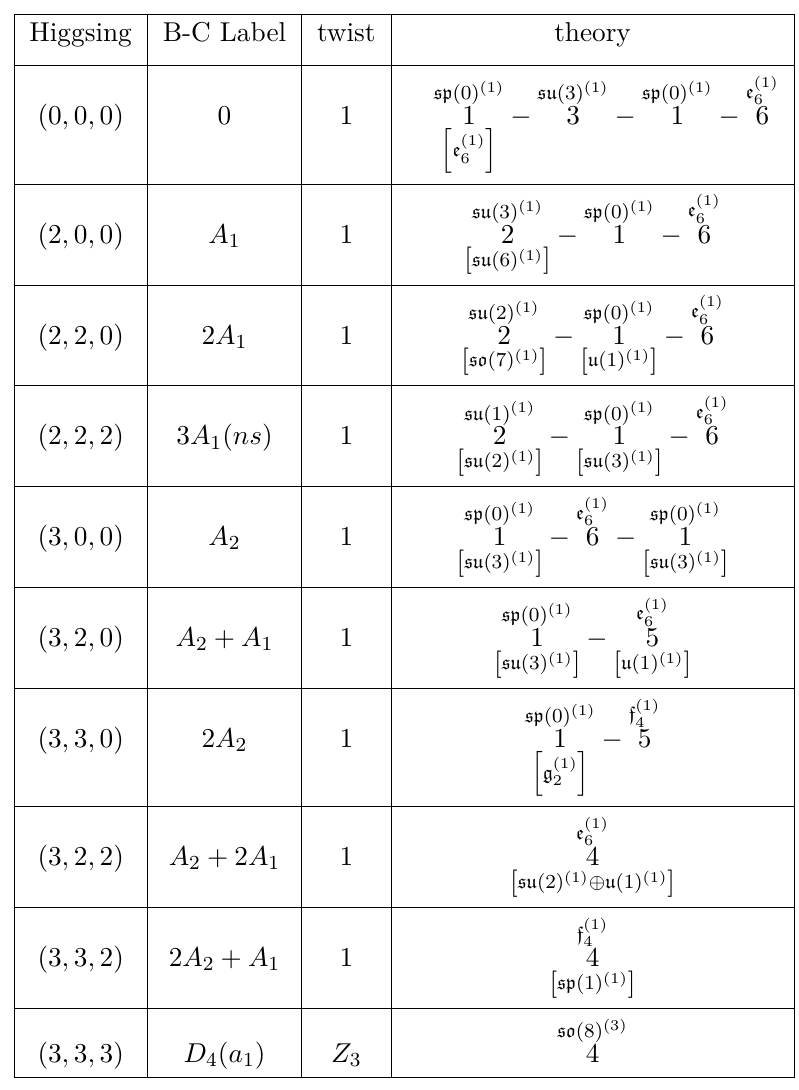
Table 3. Higgsings associated to SU(3) 3 of